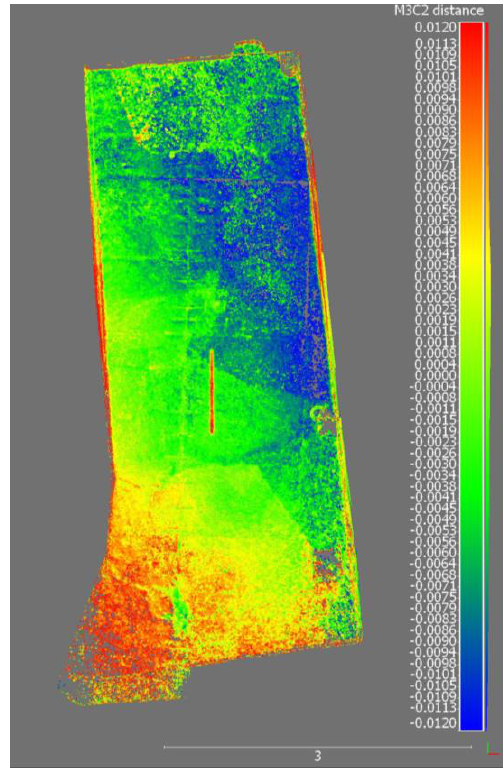
Figure 8. Colour map of the distance (m) between the models on the floor The coordinates of three points located on the meridian were determined by the measurements carried out by the total station, their coordinates have been picked also on the two